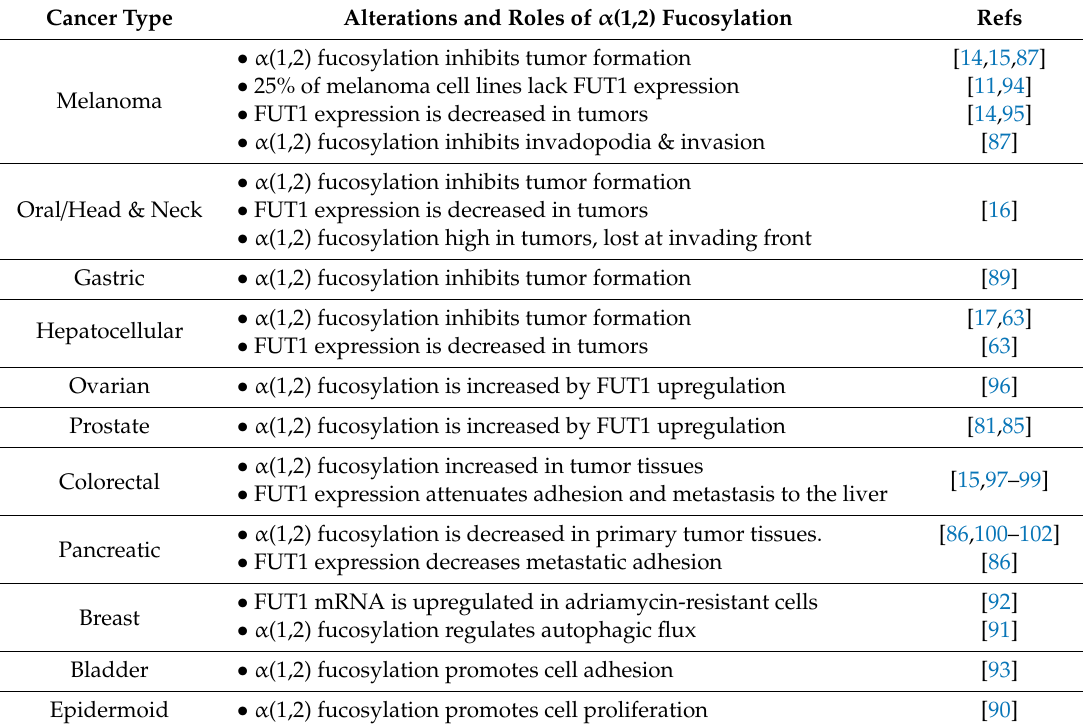
Table 4. Alterations and roles of α (1,2) fucosylation in